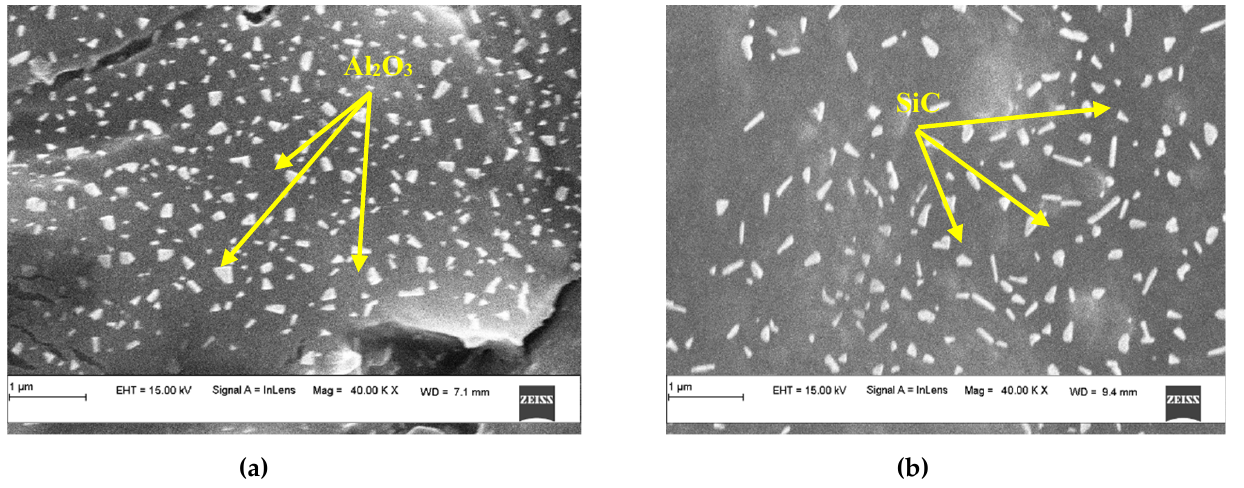
Figure 5. Dispersion of nanoparticles: ( a ) 1.75 wt.% Al 2 O 3 , ( b ) 1.25 wt.% SiC.